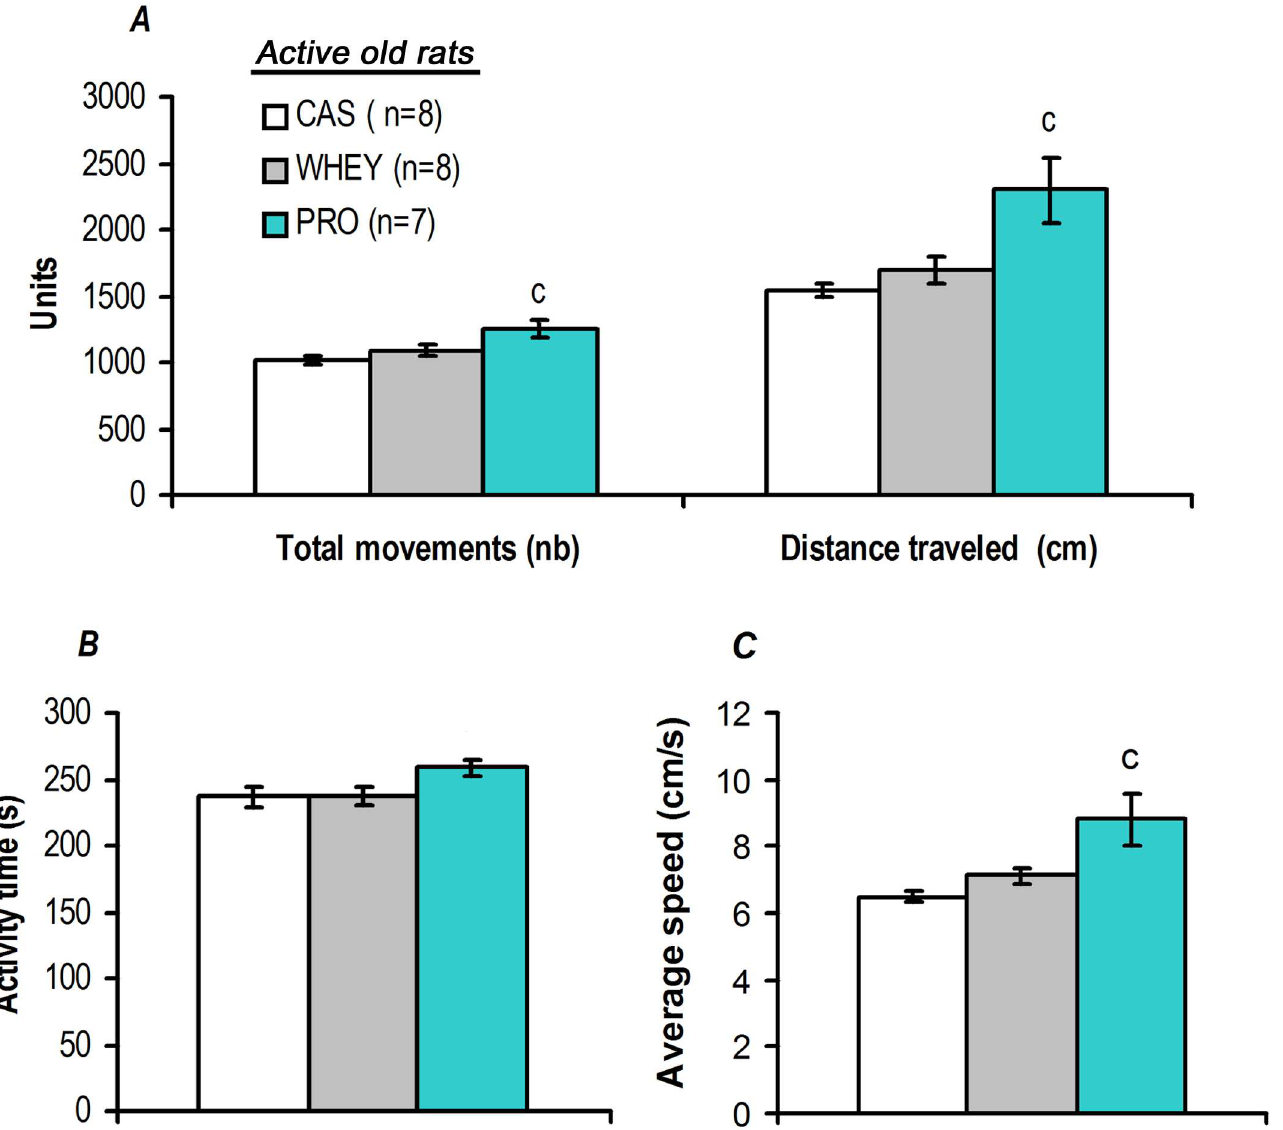
Fig 4. Active old rats supplemented with soluble milk protein exhibited higher locomotion parameters. Assessment of short-term exploration activity using an IR actimeter with 19-month-oldrats after two months of protein supplementation with a concomitantlow-intensity physicalactivity program revealedthat locomotion capacitieswere higherfor the PRO than for the CAS group. Indeed, active old rats supplemented with solublemilk protein exhibitedhighervalues in terms of the total numberof movementsand the distancetravelled( A ) and the averagespeed ( C ), than CAS group. Values are means ± SEM. c p < 0.05 vs . the CAS